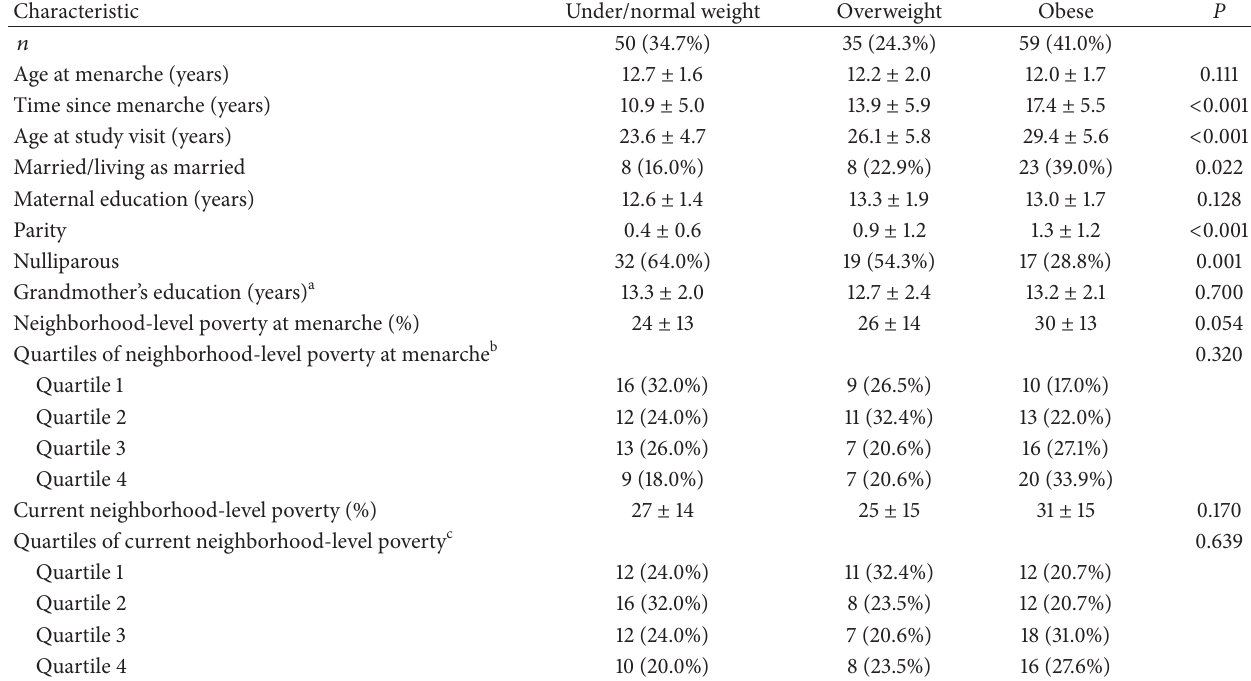
Table 1: Participant characteristics by prepregnancy BMI category ( 𝑁 = 144 ); data are mean ± standard deviation or 𝑛 (%).